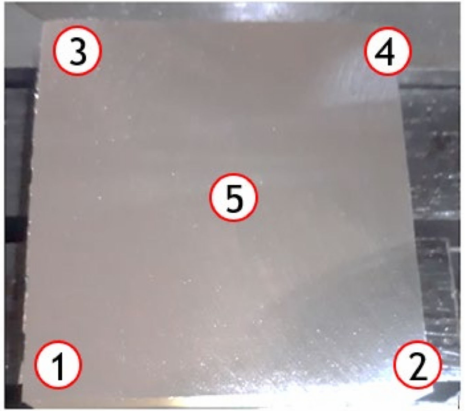
Figure 2. Details of surface roughness measurement points on aluminum alloy